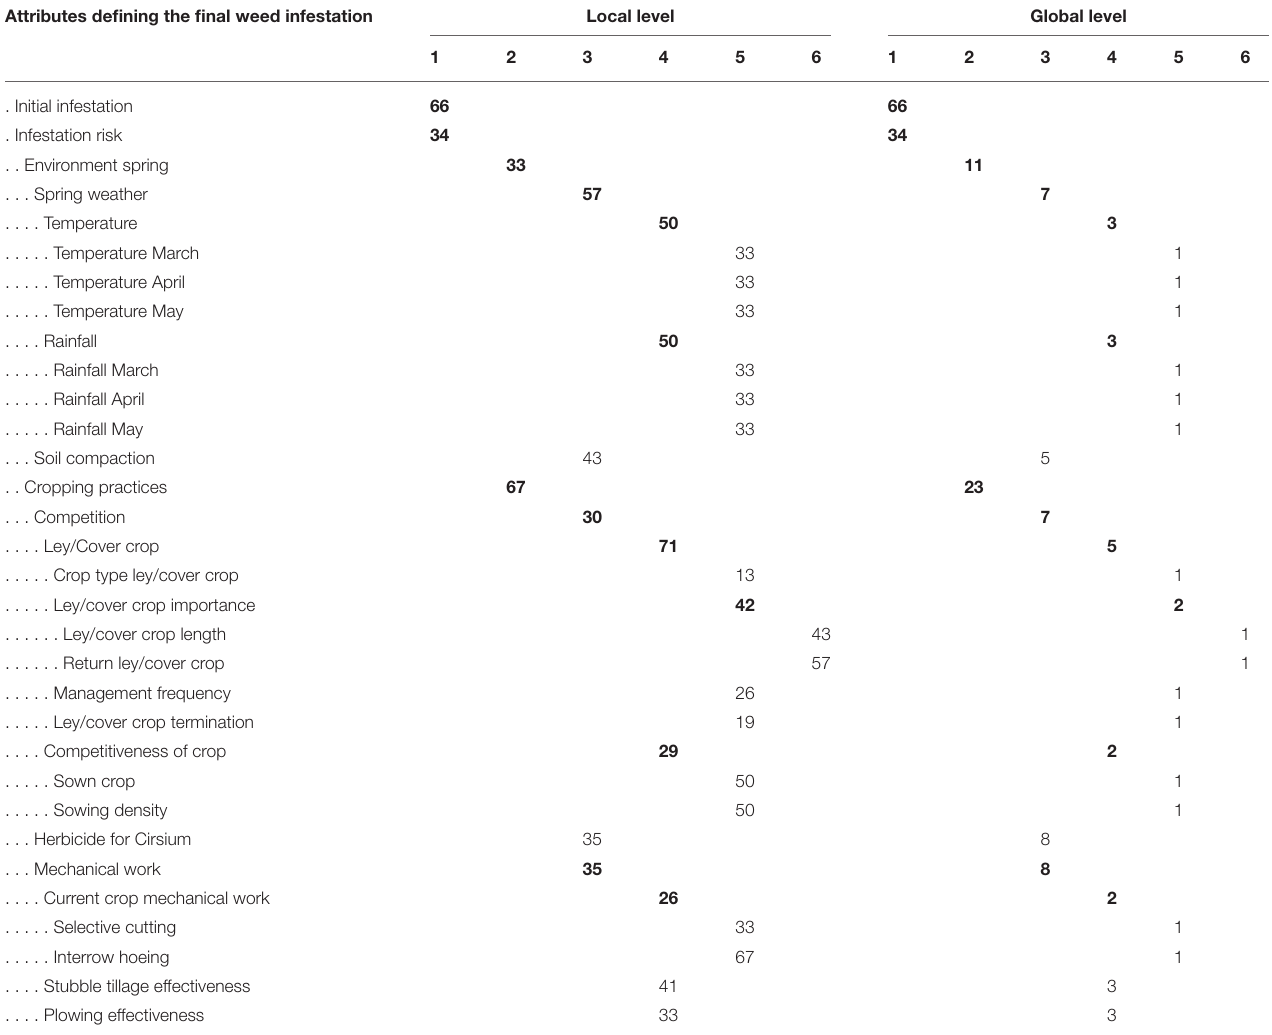
TABLE 3 | Normalized weights of IPSIM-Cirsium. Attributes defining the final weed